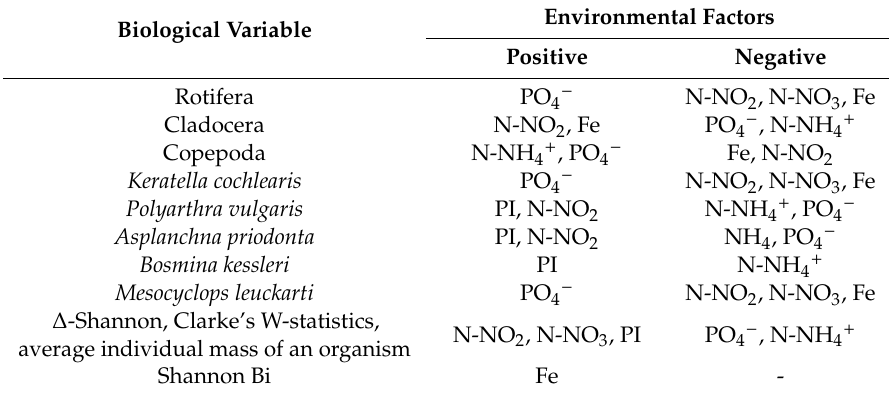
Table 5. Comparison of the results of multivariate analysis RDA.